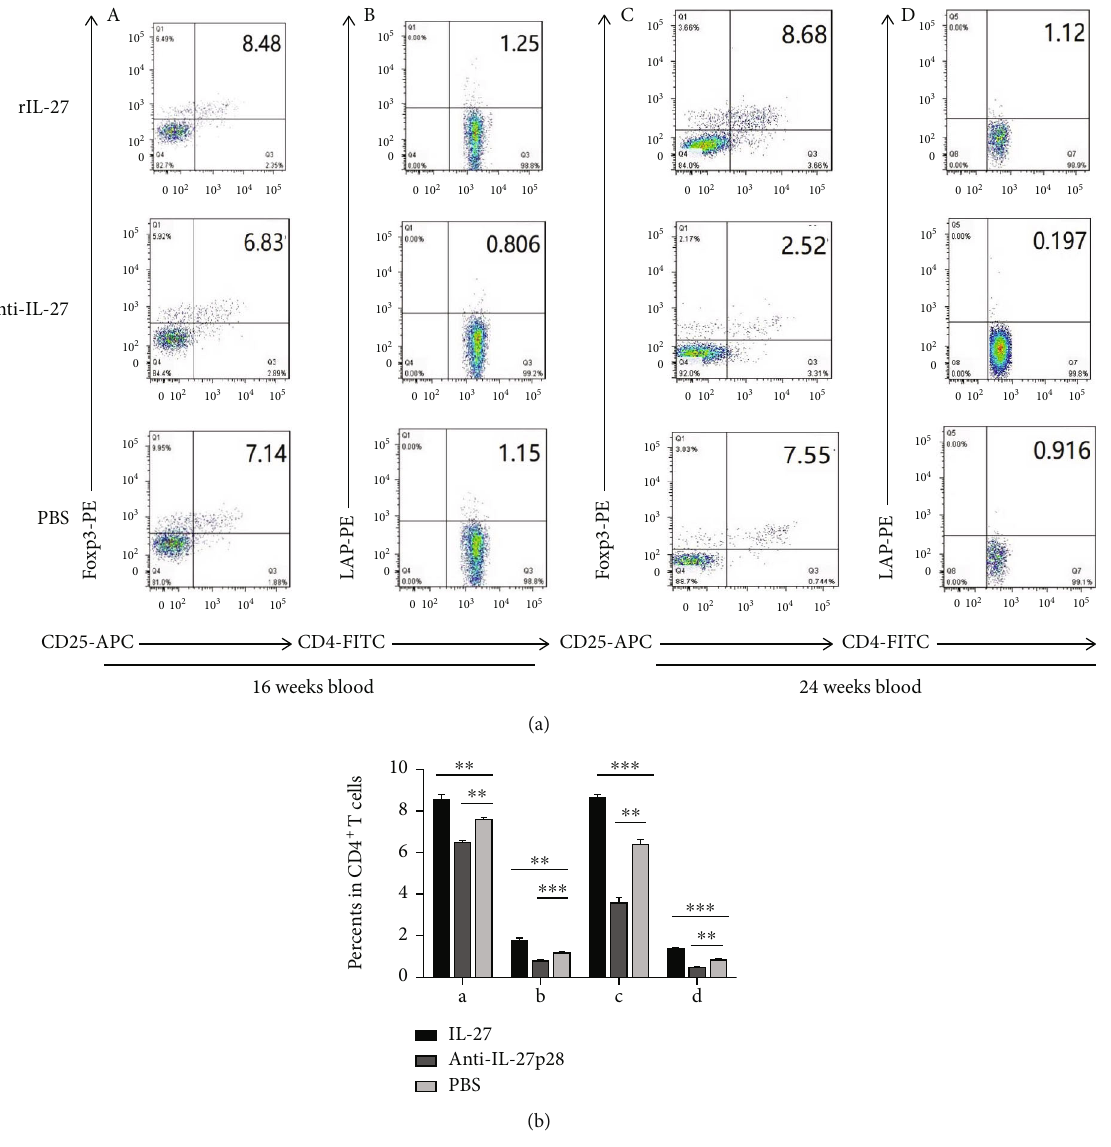
Figure 4: Recombinant IL-27 elevated the generation of Foxp3 + and LAP + Tregs in the blood of ApoE -/- mice. (a) In the blood, the fractions of Foxp3 + and LAP + Tregs were measured by fl ow cytometry. (A) and (B) show the fractions of Foxp3 + Tregs (A) and LAP + Tregs (B) during the initiation of atherosclerosis. (C) and (D) show the fractions of Foxp3 + Tregs (C) and LAP + Tregs (D) during the progression of atherosclerosis. (b) Groups data are shown in histogram. ∗∗∗ P < 0 : 001 , ∗∗ P < 0 : 01 , ∗ P < 0 : 05 fold , respectively; P = 0 : 003 ), and IL-17 ( 2 : 00 ± 0 : 30 vs 1 : 00 ± 0 : 03 − fold , P = 0 : 004 ) levels were increased in the